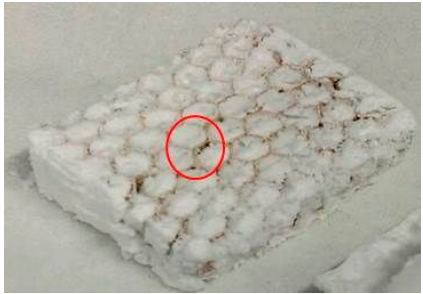
Figure 6. Super-flexible silica aerogel (SA1) with aramid honeycombs A10-92-5.2.